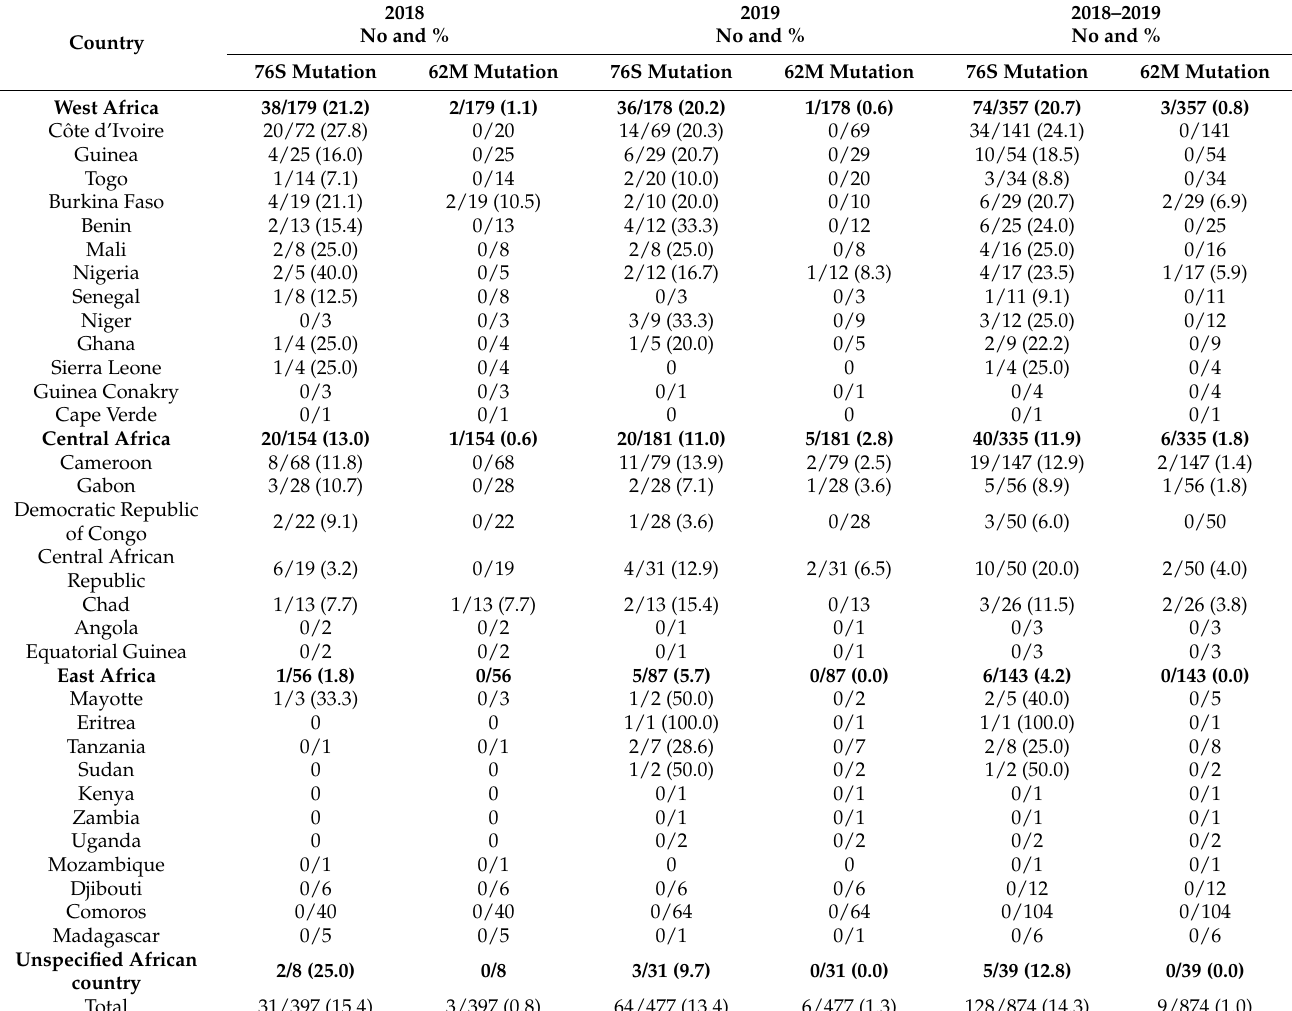
Table 2. Proportion of pfcoronin 76S and 62M mutations in Plasmodium falciparum isolates per country and per year.